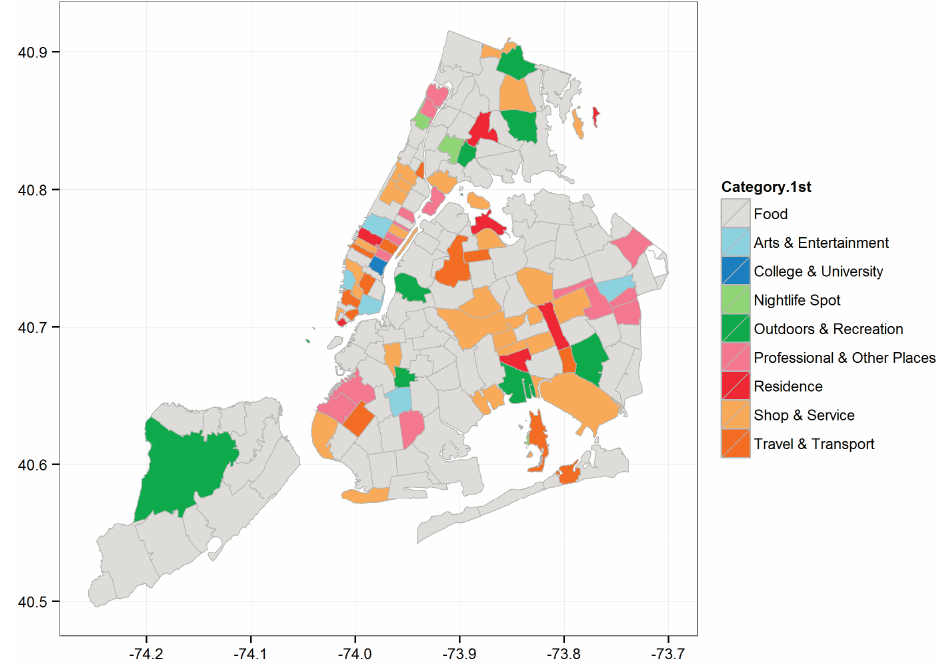
Figure 3. Dynamics of functional configurations within New York